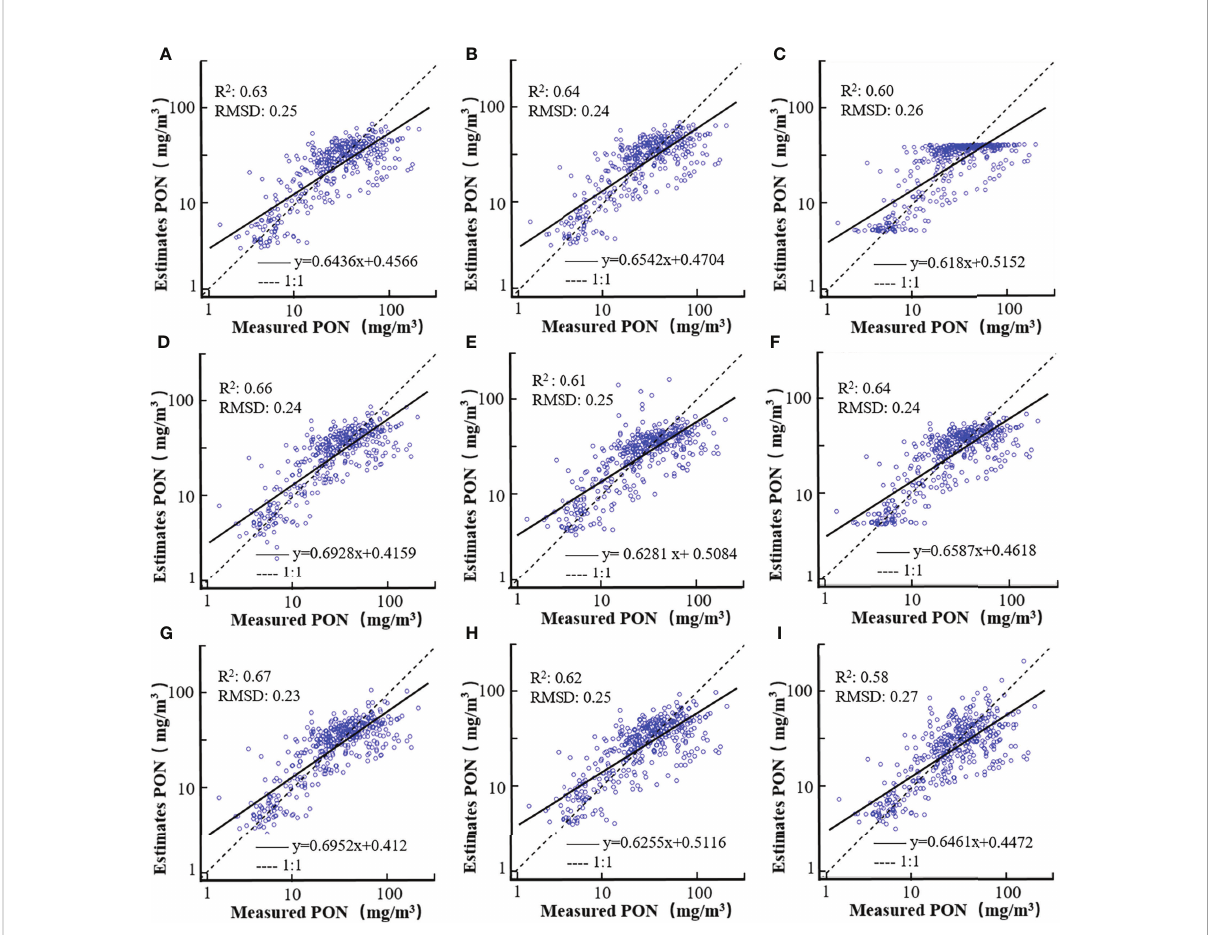
FIGURE 5 Scatterplots of estimated vs. measured PON concentrations for models based on a (469) (A) , a (488) (B) , bbp_s (C) , BG (D) , CI (E) , MBR (F) , NDNI (G) , CHL (H) , and POC (I) . Both axes are in log10